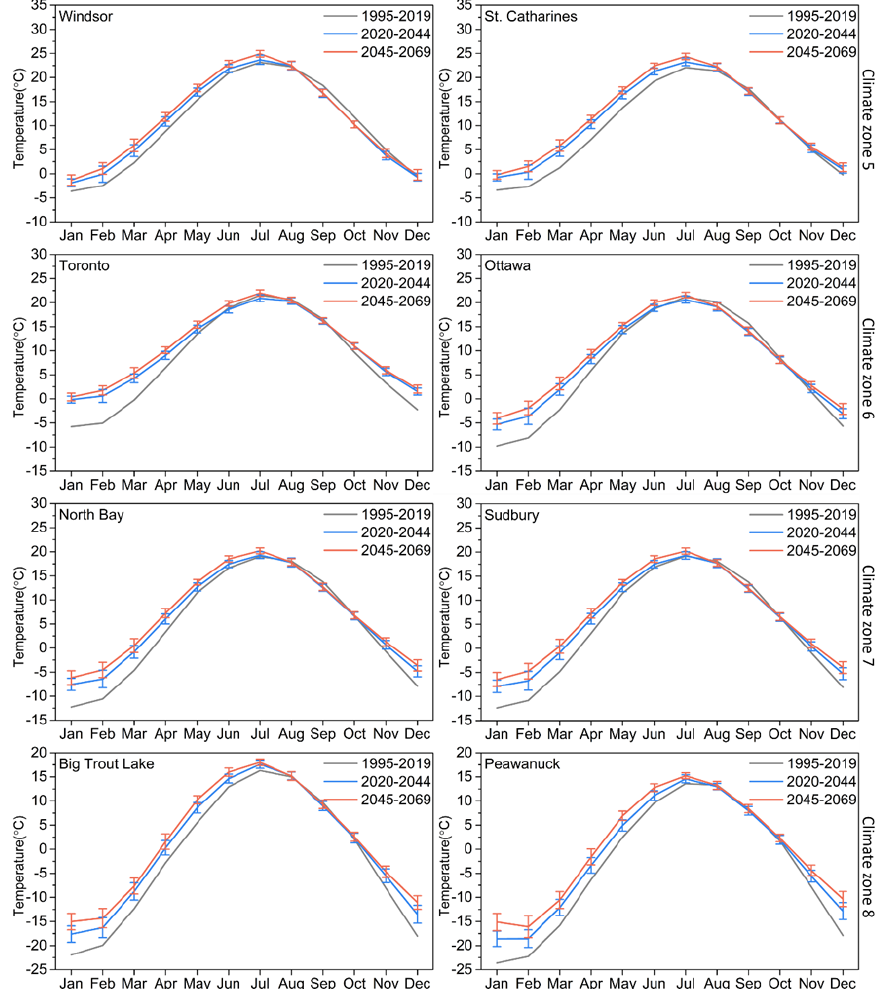
Figure 3. Historical (1995–2019) and future (2020–2069) monthly average temperature for the selected cities. Table 4. Monthly temperature difference between 1995 and 2019 and 2020 and 2044 for the 8 cities.